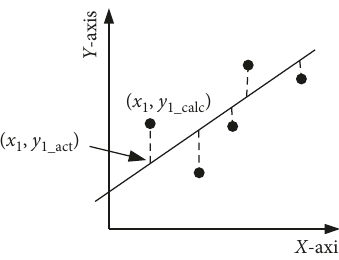
Figure 3: Coefficient of determination explanatory sketch.